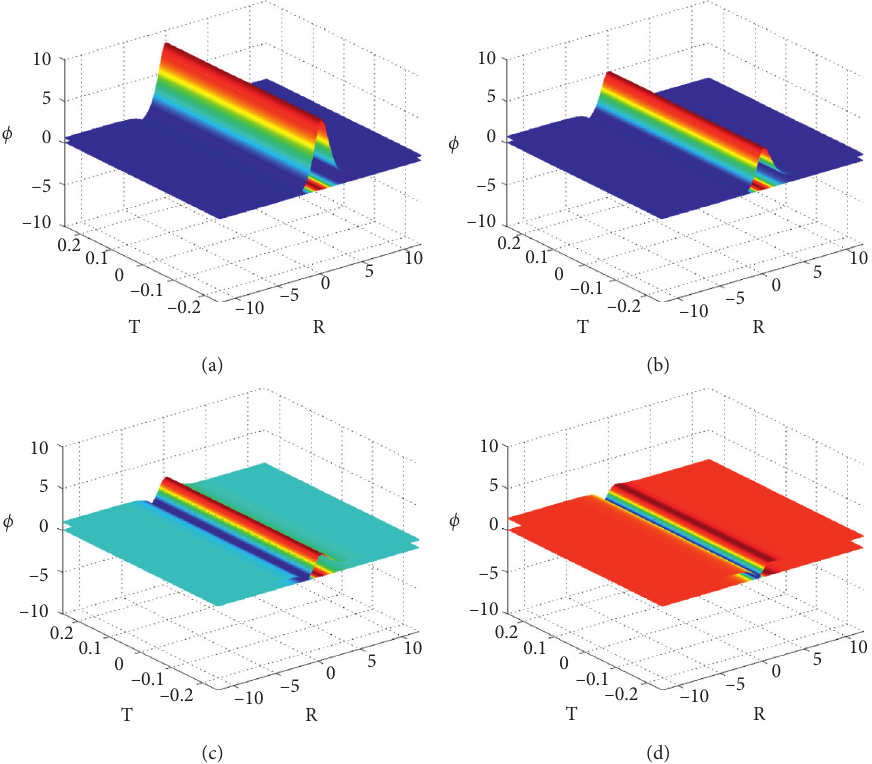
Figure 4: The values of the parameters are as follows. (a) β � 1 . 2, λ � 1 . 1, ω � 1, and ϖ � 1. (d) β (c) β 1